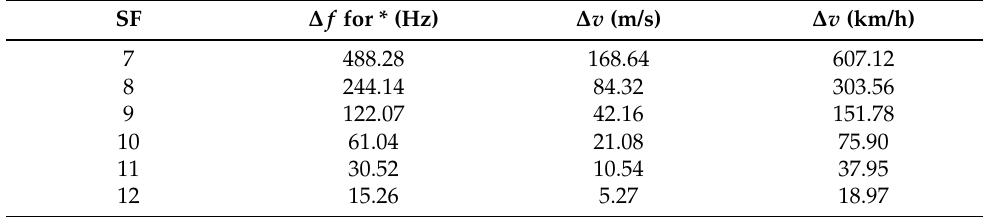
Table 1. Reference values for ∆ f and ∆ v for a normalized Doppler shift of 0.5. ( B = 125kHz and F = 868MHz).